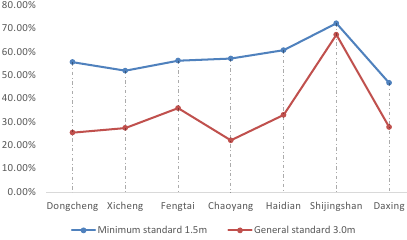
Figure 8. Assessment map of Road environmental indicators